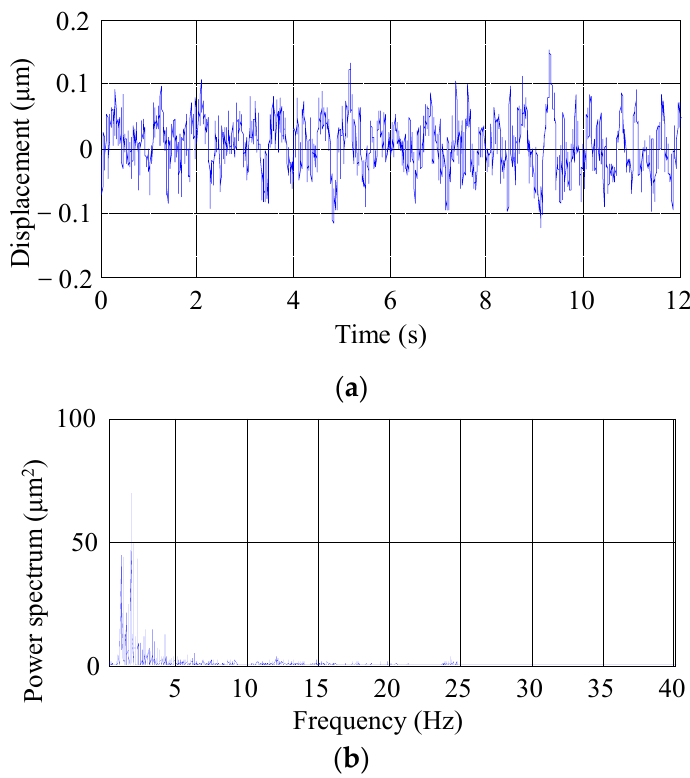
Figure 7. Superimposed signal of multiple vibration sources: ( a ) Time history curve; ( b ) CS.